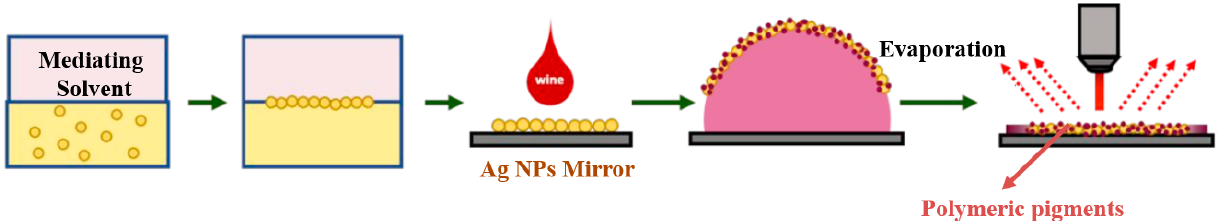
Figure 38. Schematic illustration of the chemical information of red wines with SERS through several sample preparation methods [155].